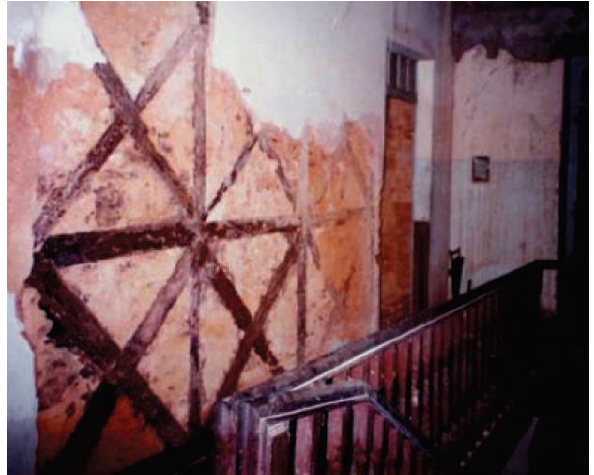
Figure 5. Wall evidencing the Santo Andr´e cross structure. (Figueiredo et al., 2011) their state of conservation. During this phase, photogrammetry